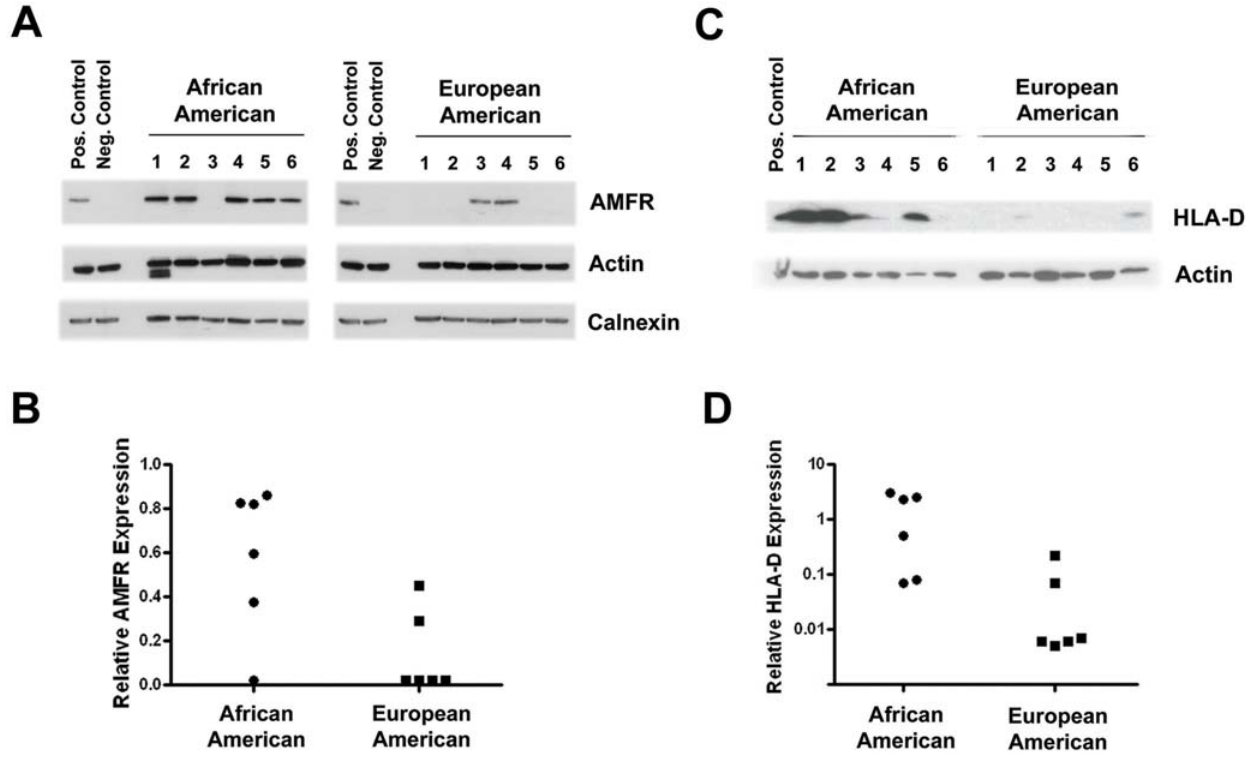
Figure 3. Autocrine mobility factor receptor (AMFR) and HLA-D protein expression in breast tumors. (A) Shown is the protein expression of AMFR in extracts of 6 tumors from African-American patients and 6 tumors from European-American patients. b -actin and calnexin are loading controls. Like AMFR, calnexin is located in the endoplasmic reticulum. (B) Quantification of AMFR expression. Shown is the relative expression of AMFR protein after normalization to b -actin. AMFR expression is significantly higher in tumors from African-American patients than in tumors from European-American patients ( P =0.038; Wilcoxon rank sum test). (C) Differential HLA-D protein expression in ER-negative breast tumors. Shown is the expression of HLA-D in extracts of 6 tumors from African-American patients and 6 tumors from European-American patients. (D) Quantification of HLA-D expression. Shown is the relative expression of HLA-D protein after normalization to b -actin. The expression is significantly higher in tumors from African-American patients than in tumors from European-American patients ( P =0.016; Wilcoxon rank sum test).